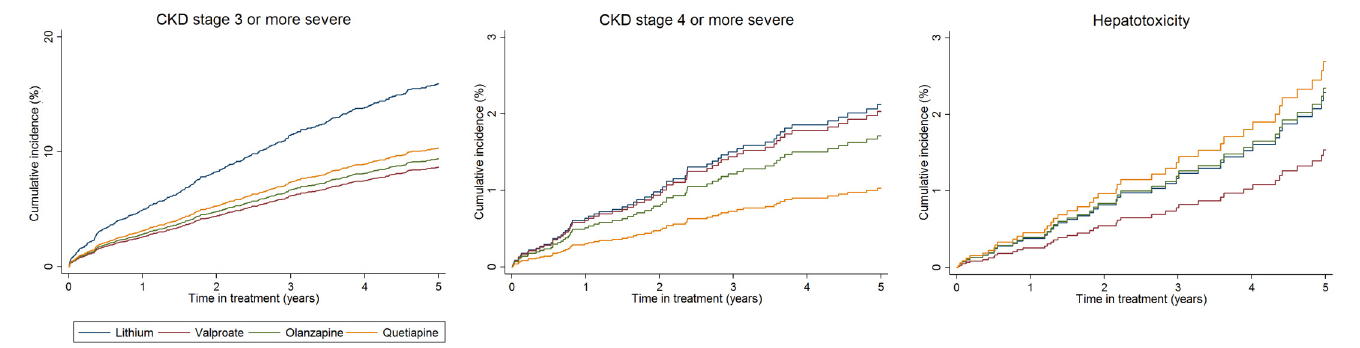
Fig 1. Cumulative incidence estimates of adverse renal and hepatic event rates. From PS and age-adjusted competing-risks regression. Note differences in scale of y -axis for each plot.